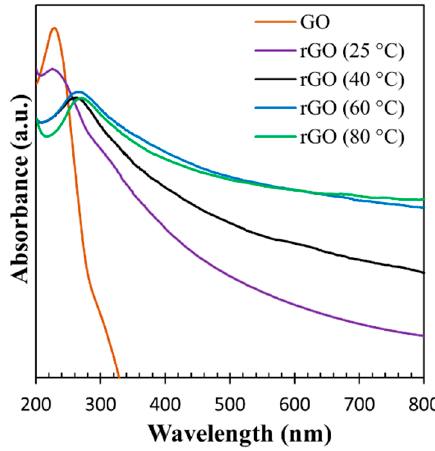
Figure 3. UV-vis spectra of the reaction mixture of the reduction of GO to rGO using lemon juice at different temperatures (conditions: pH = 12.3 and 2 h).